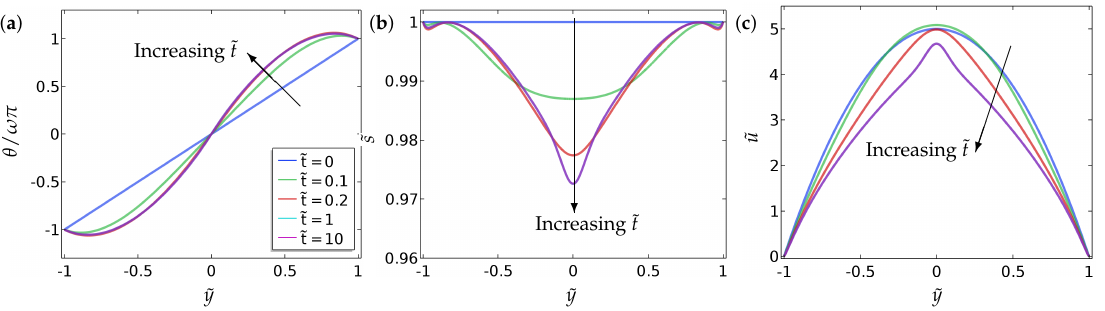
Figure 11. The dynamic evolution of ( a ) the director orientation ( θ ) , ( b ) the order parameter ( ˜ s ) and ( c ) the velocity profile ( ˜ u ) for the symmetric case (Equation 15). The values of the parameters used are ω = 1/2, L ∗ = 10 − 3 , L 2 = 10, ˜ p x = 10 and L 1 = 10 − 6 . The legends of all the sub-figures are the − same as in ( a ).